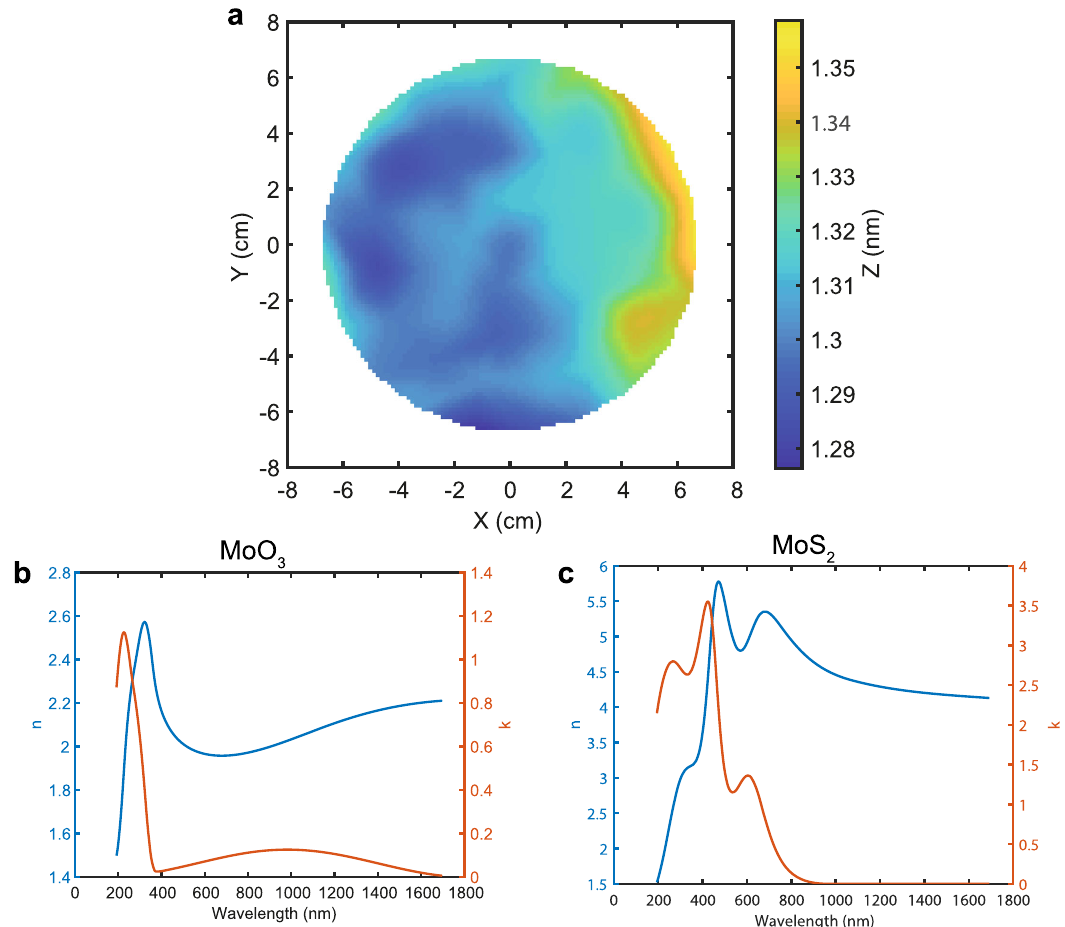
Fig. 1 MoO3 Ellipsometry results on SiO2/Si. a 6-inch wafer thickness mapping. b Real and imaginary part of the refractive index of MoO 3 . c Real and imaginary part of the refractive index of MoS 2